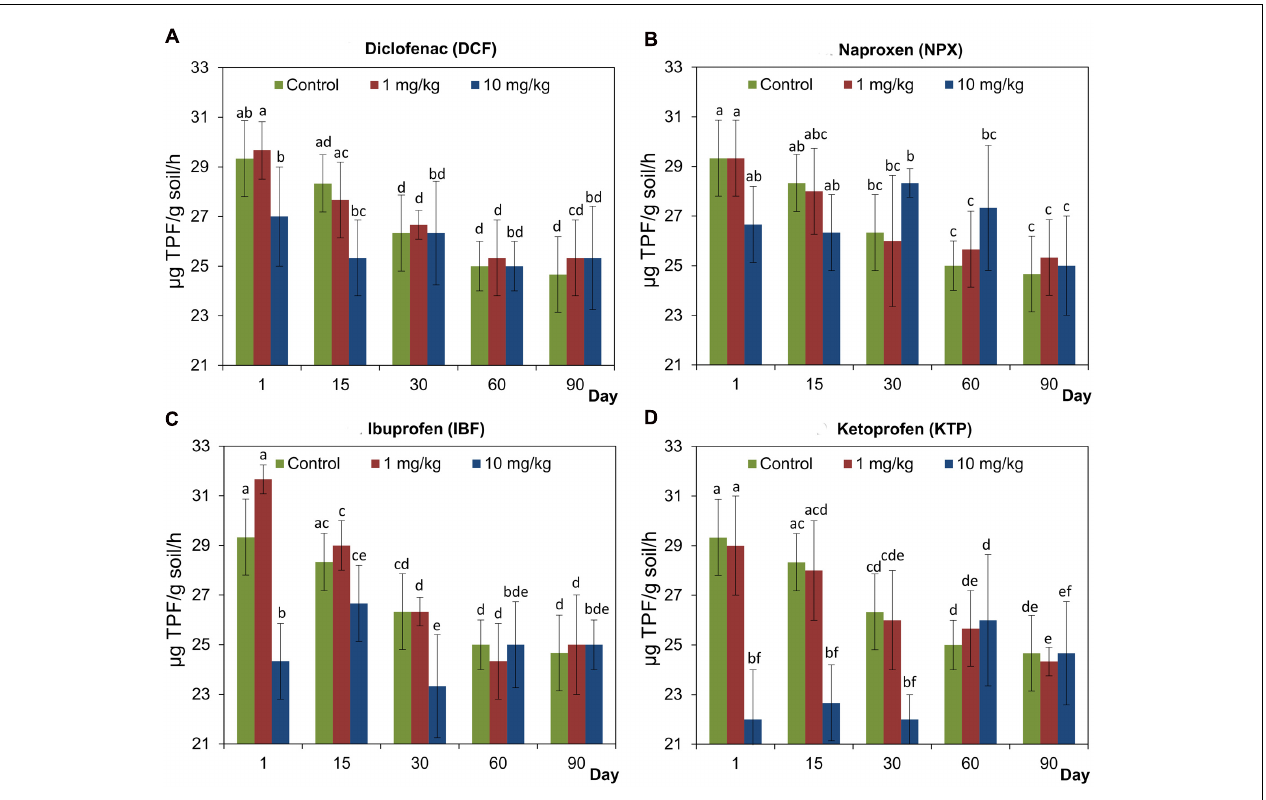
FIGURE 3 | Dehydrogenase (DHA) activity in control soil and soil treated with diclofenac (A) , naproxen (B) , ibuprofen (C) , and ketoprofen (D) at concentrations of 1 and 10 mg/kg soil during the 90-day experiment. The data presented are the means and standard deviations of three replicates and are expressed as µ g TPF/g soil/h. Different letters (within each drug) indicate significant differences ( P < 0.005, LSD test) related to the effects of concentration and